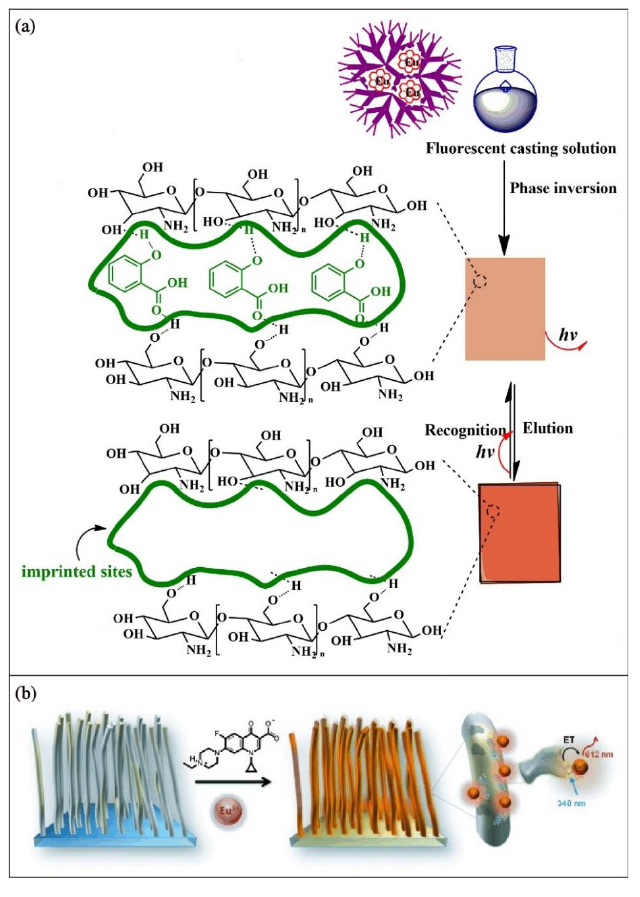
Figure 5. Schematic illustration of ( a ) preparation and sensing mechanism of fluorescence molecularly imprinted membrane for salicylic acid detection. Adapted with permission [70]. Copyright 2019, Elsevier. ( b ) Fabrication of enrofloxacin-imprinted nanofilament entrapped with Eu(III) ions for enrofloxacin detection. Adapted with permission [71]. Copyright 2013, Wiley-VCH.